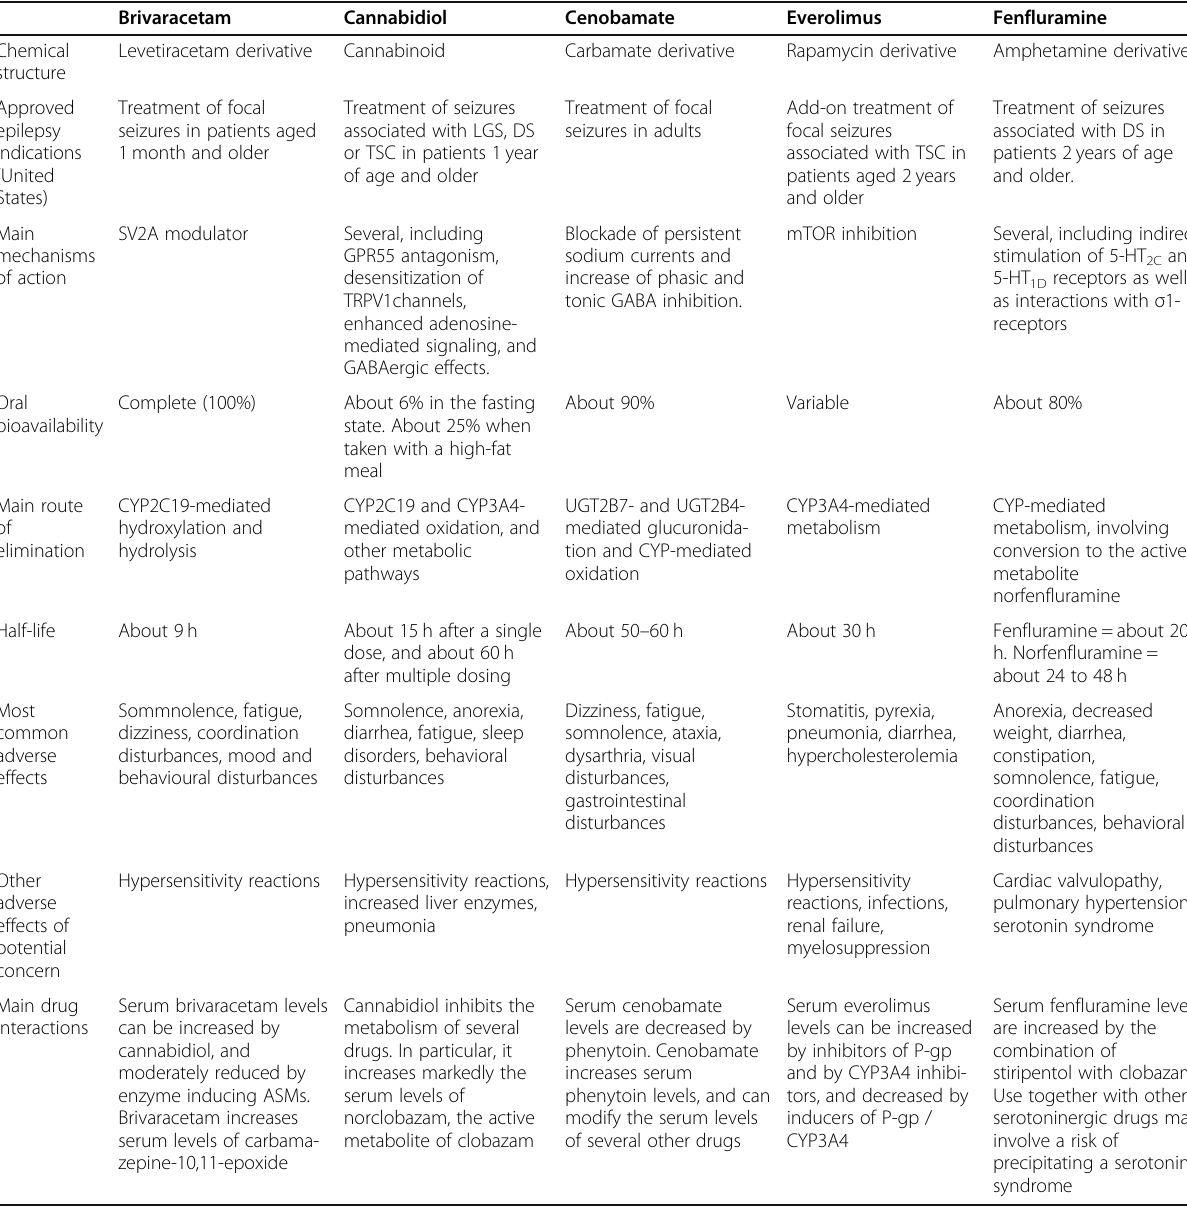
Table 2 Summary of the pharmacological and clinical profile of antiseizure medications (ASMs) introduced in the market after